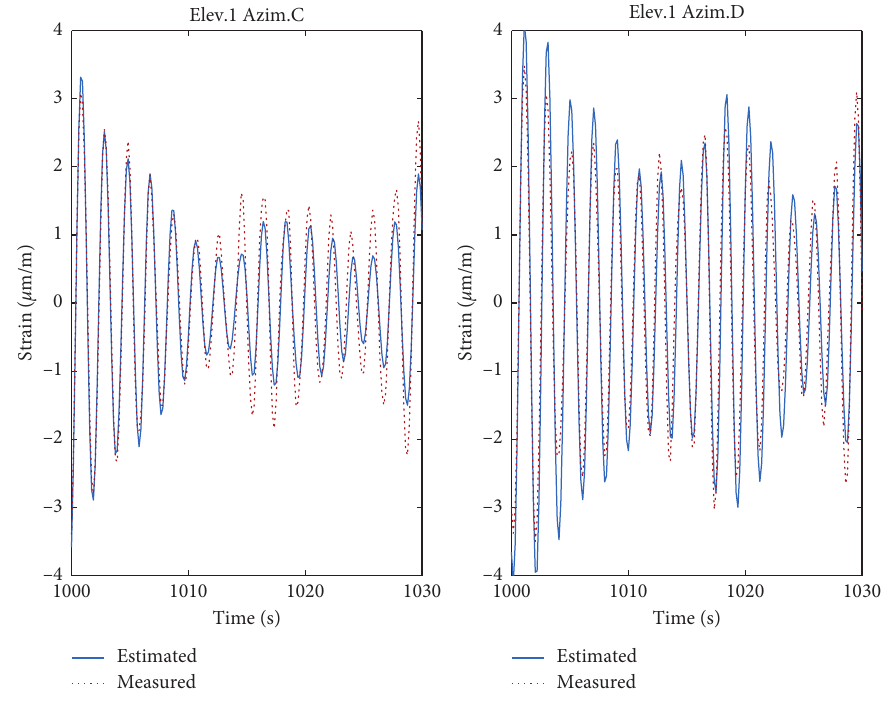
Figure 6: Strain history at Elevation 1 for dataset 14.